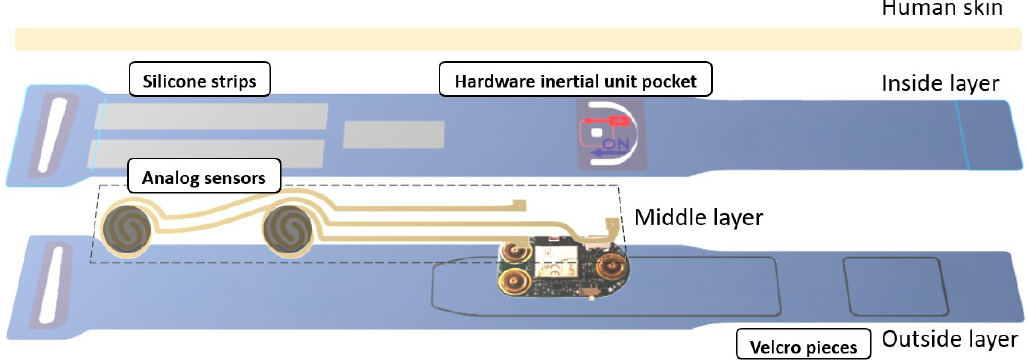
Figure 7. Customized textile band for sensors integration and attachment to the human body.